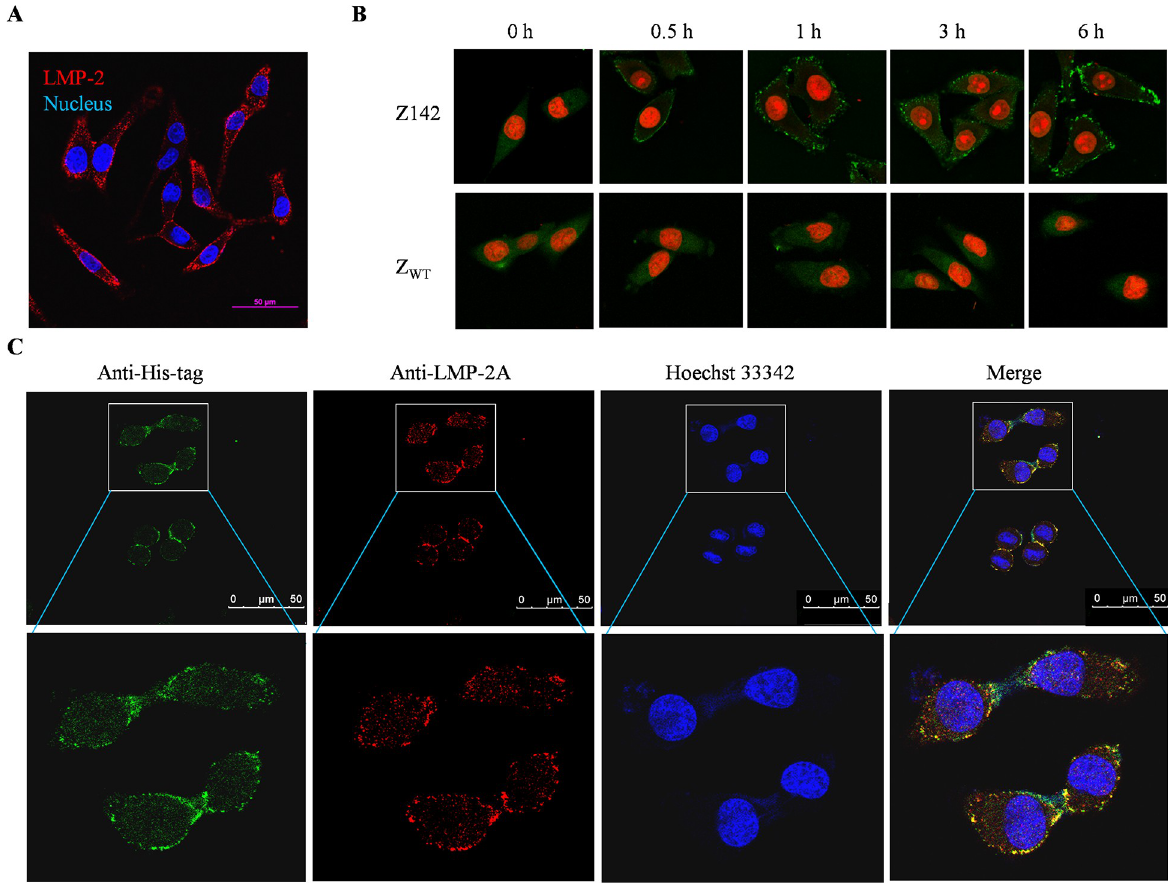
Fig 2. Z142 affibody and rat anti-LMP-2A mAb recognize the same native membrane-bound LMP-2 expressed in NPC-derived EBV + C666-1 cells. (A) Membrane LMP-2 staining profile of C666-1 cells by IFA using a rat anti-LMP-2A mAb. (B) Constant binding of Z142-His affibody to membrane LMP-2 expressed in C666-1 cells was examined by anti-His-tag IFA at the indicated incubation time (hr) of the Z142 affibody. (C) Representative Z142-His affibody (green) and anti-LMP-2A (red) co-staining of native membrane-bound LMP-2 expressed in C666-1 cells. The cell nuclei were stained by Hoechst 33342 (blue). The merged images showed the LMP-2 specific co-staining (yellow). Scale bar, 50 μ m.